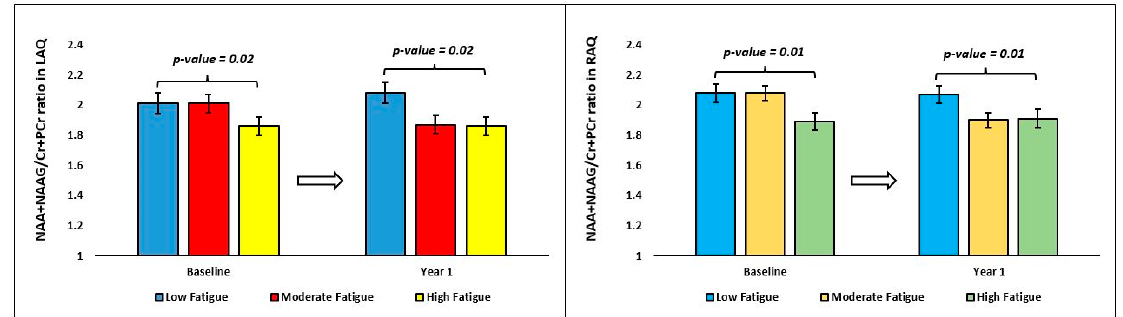
Figure 4. Bar graphs representing the mean and standard error of mean (SEM) of NAA+NAAG/Cr+PCr ratio in right anterior quadrant (RAQ) and left anterior quadrant (LAQ) between the fatigue groups at baseline and year 1. The p -value represents the statistical significance of pairwise comparisons in the two-way ANOVA.